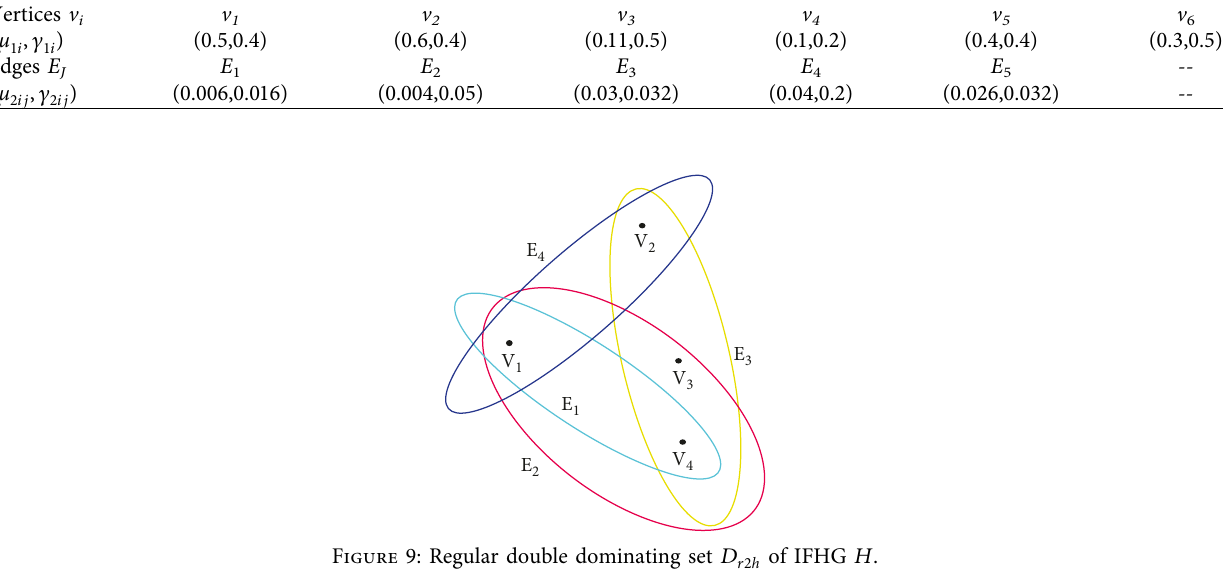
Table 8: Degree of membership and nonmembership values for vertices and edges of Figure 8.